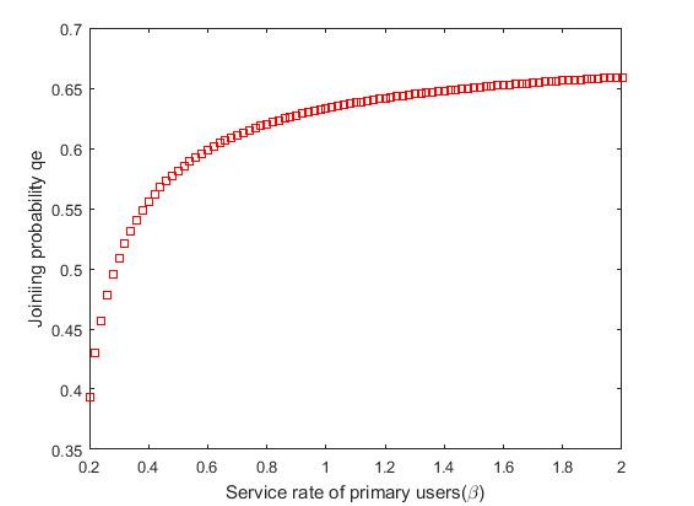
Figure 4. Equilibrium-joining probabilities vs. β when α = 0.2, λ = 0.4, µ = 1, θ = 0.7, η = 0.5, C = 1, R = 15.